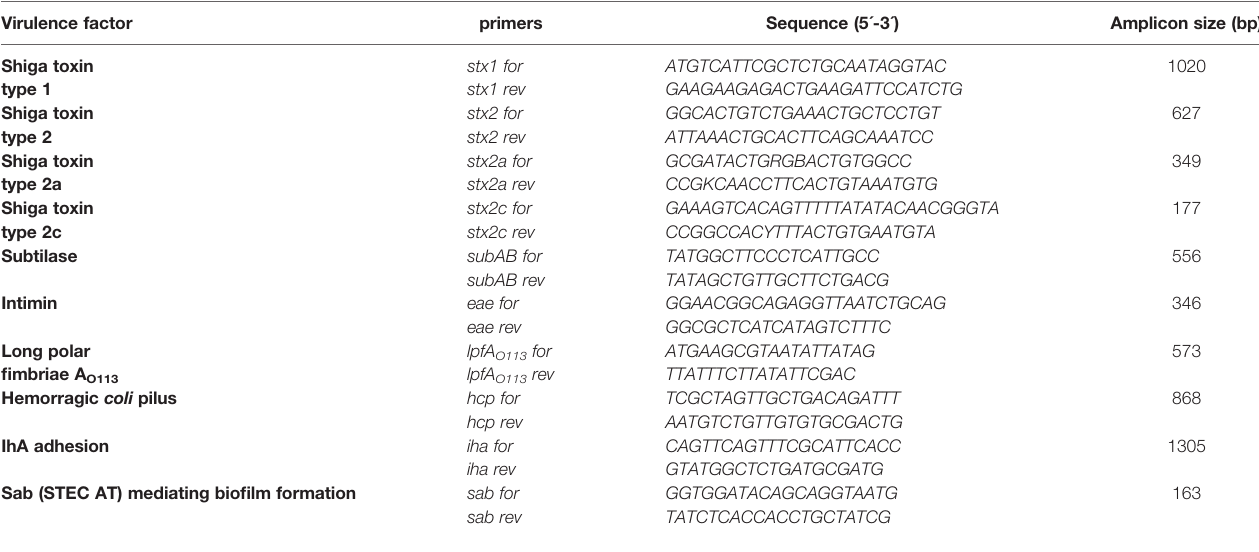
TABLE 2 | Evaluation of STEC virulence factors, primer sequences and size of amplicons .